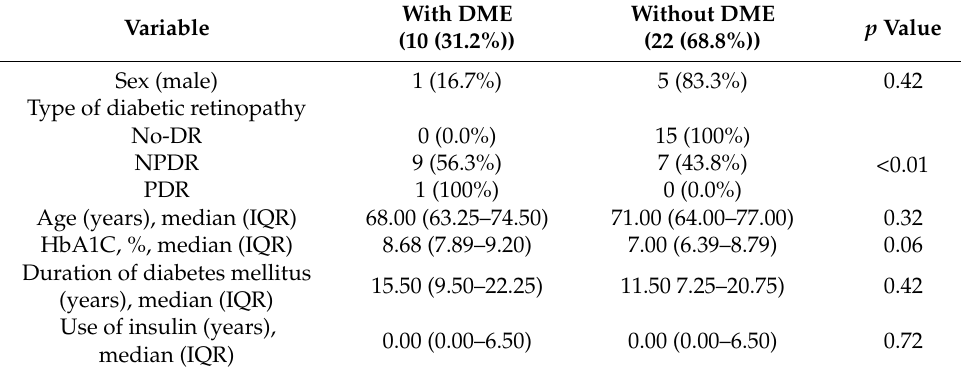
Table 1. Baseline characteristics of the study